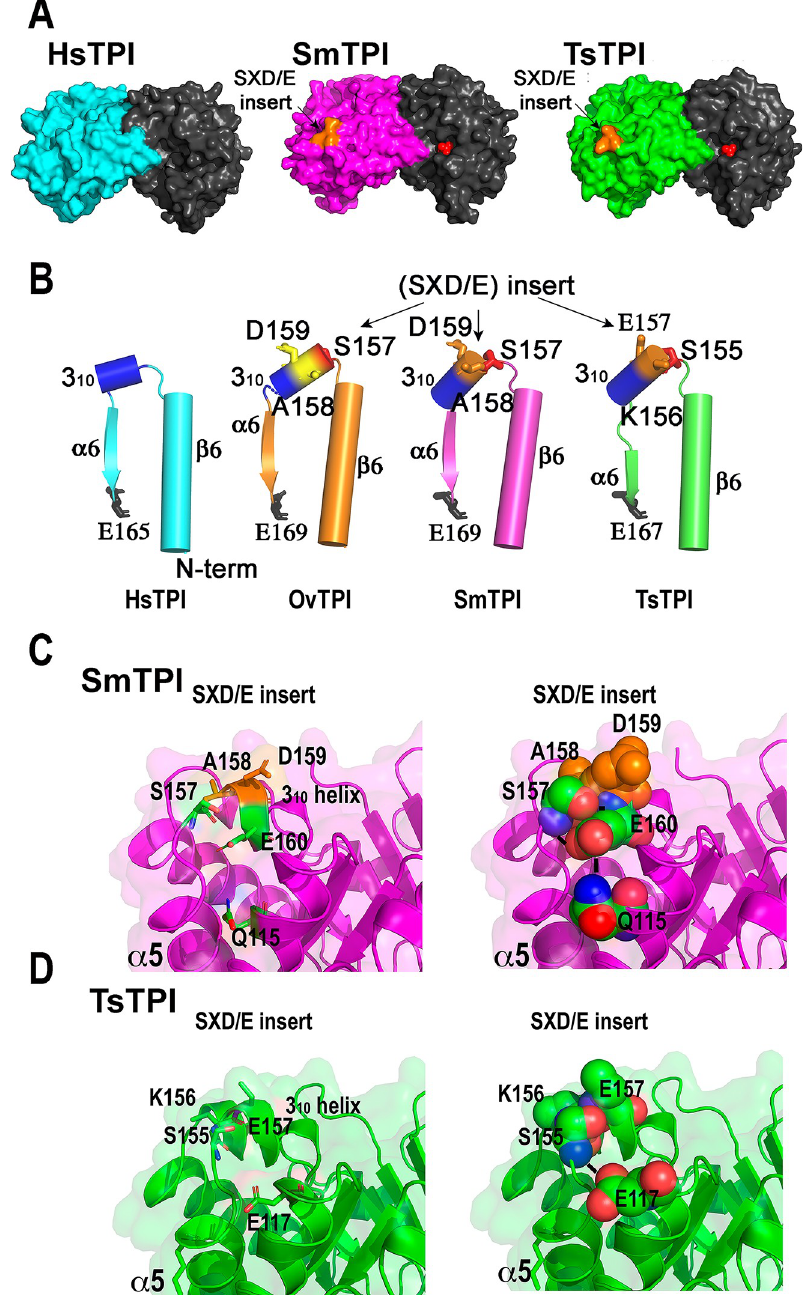
Fig 4. Structural localization of the SXD/E insert in TPIs from helminths. A) Surface representation of human and helminth TPIs focusing on the immunogenic SXD/E insert. The hook-like structure that adopts the SXD/E insert in both SmTPI and TsTPI is colored in orange B) Ribbon representation of the α 6, 3 10 -helix, and β 6 in representative TPIs. The SXD/E insert of SmTPI and TsTPI are colored in orange and in yellow for OvTPI. C and D ) Close view of the hydrogen bond interactions that stabilize the SXD/E insert in SmTPI and